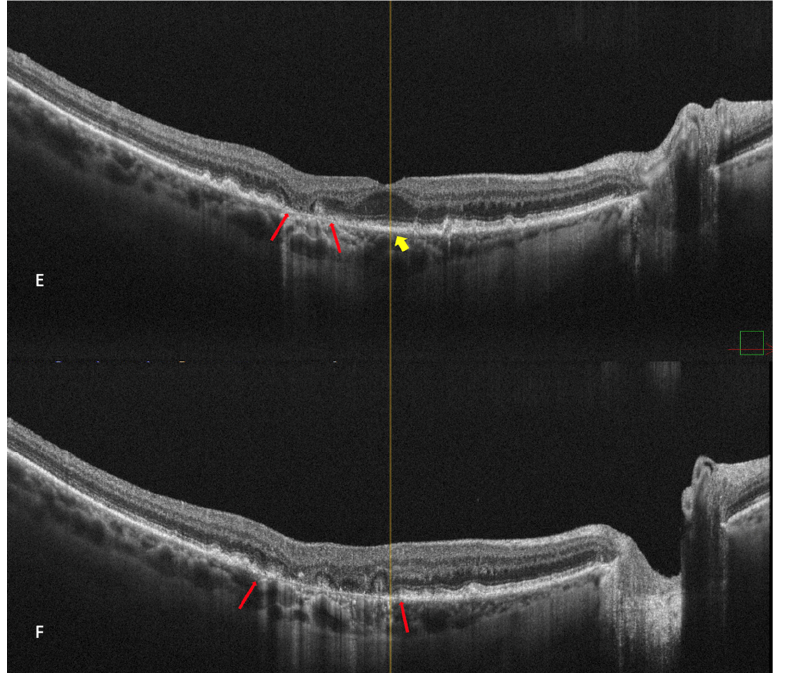
Figure 6. Geographic atrophy. ( A ) cSLO image showing round patches of GA where the choroidal vessels are visible, surrounded by large and medium drusen. ( B ) Green FAF showing confluent hypo-autofluorescent areas. ( C ) DR and ( D ) DL retromode images of GA seen as round patches with homogenous reflectivity where the underlying choroidal vessels are visible. ( E ) SD-OCT showing RPE and outer retinal atrophy temporal to the fovea (red arrows) with foveal sparing (yellow short arrow). ( F ) SD-OCT showing large area of RPE and outer retinal atrophy (red arrows).